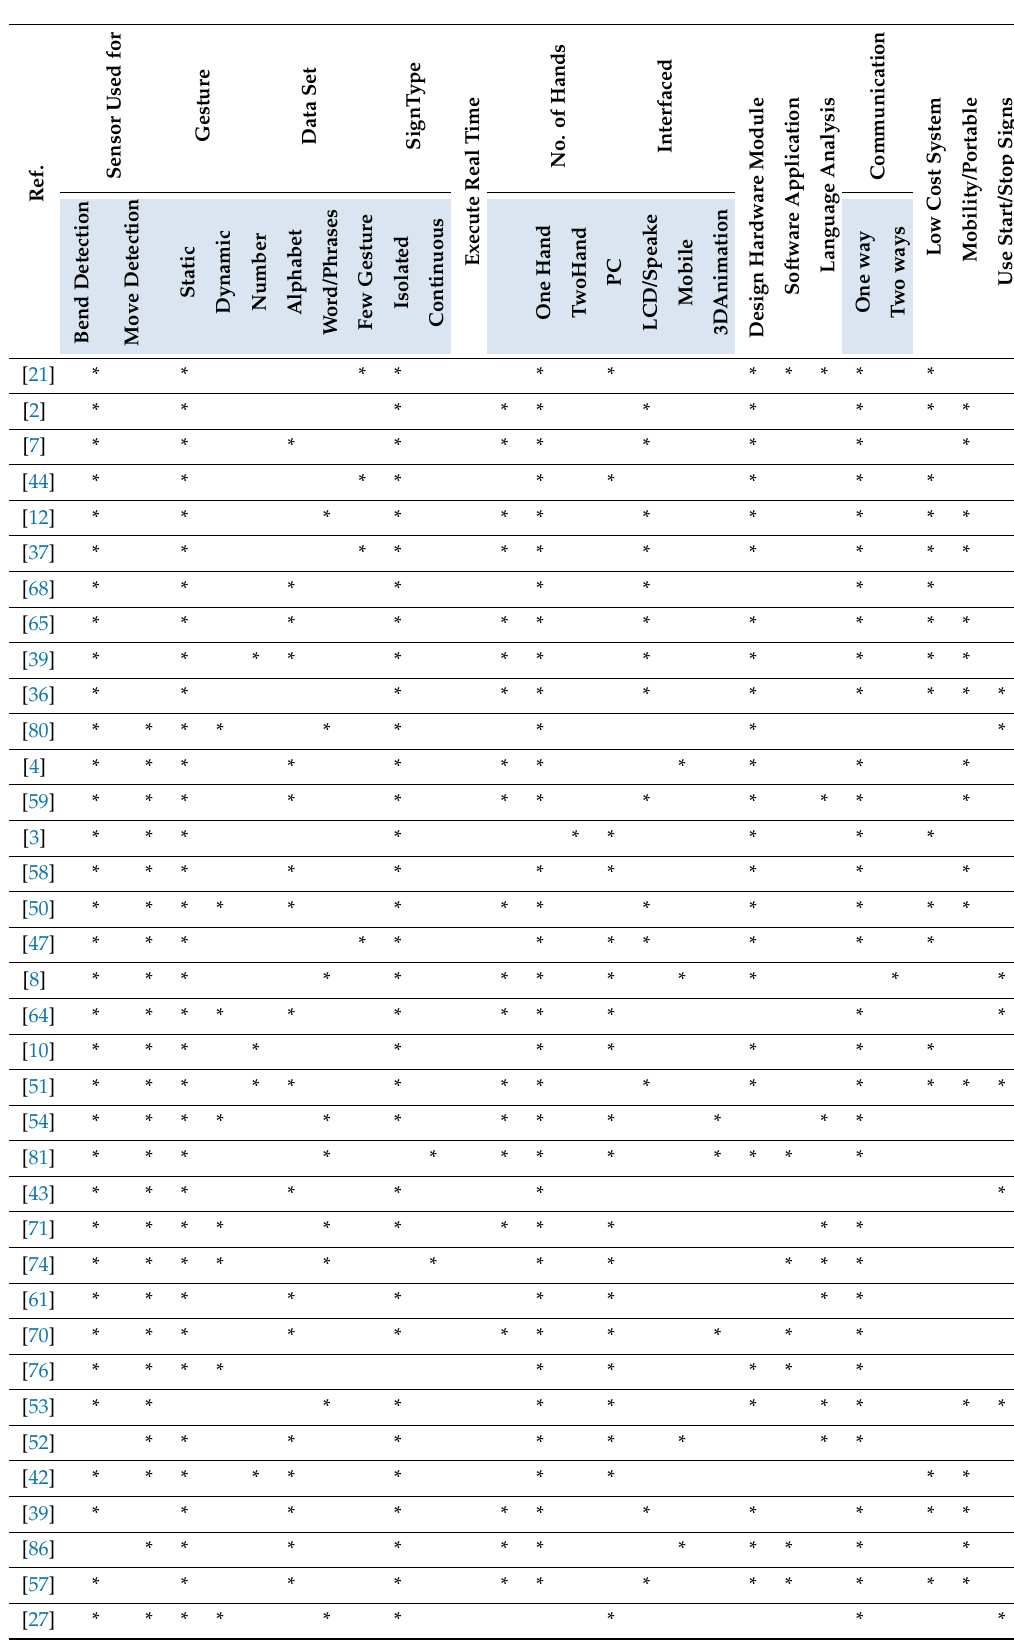
Table 3. Summary of the most important issues in previous